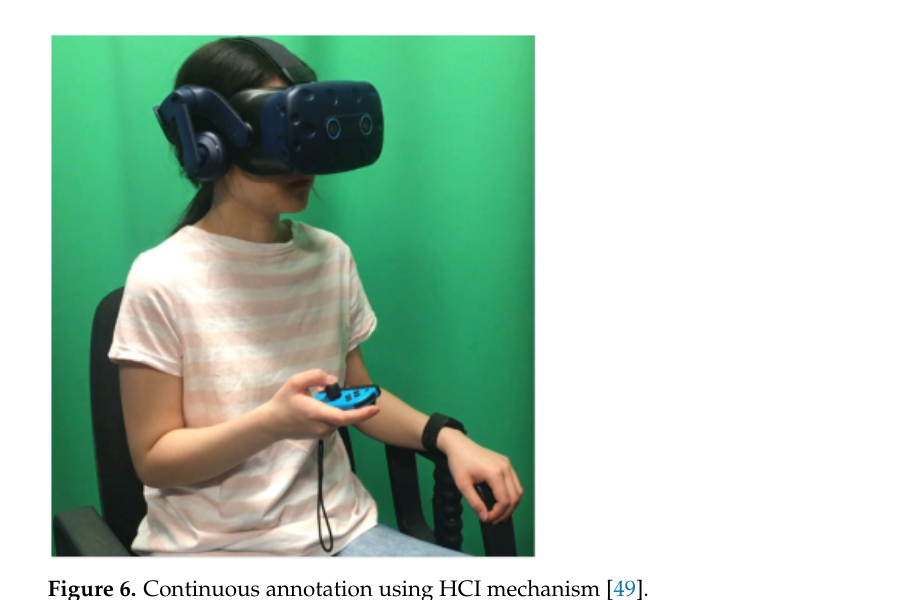
Figure 6. Continuous annotation using HCI mechanism